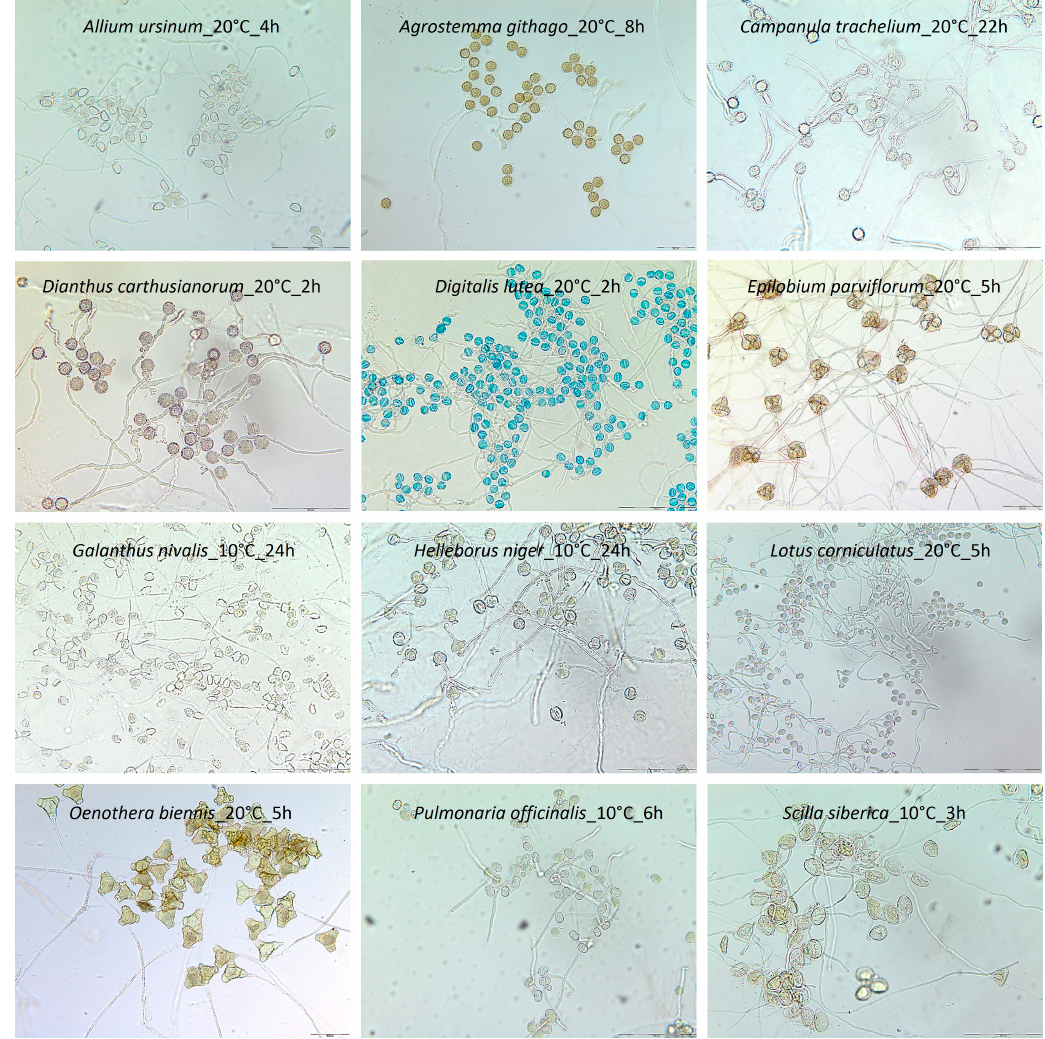
Figure 3. In vitro pollen germination and pollen tube growth in the study species in alphabetical order. Pictures show the appearance in the optimum temperature range for germination after pollen tube growth had been stopped with glycerol. Scale = 200 µm.